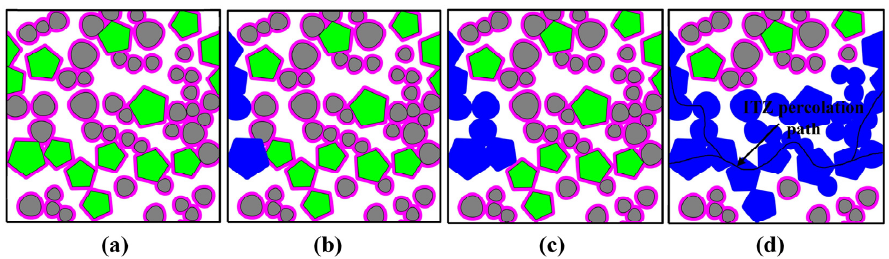
Figure 6. Schematic diagram of the searching procedure for the ITZ percolation paths around both oval fine particles and polygonal coarse particles: ( a ) The generation of 2D polyphase model; ( b ) The identification of the particles that can intersect with the left edge; ( c ) The identification of the particles that intersect with the labeled particles; ( d ) The realization of the ITZ percolation path.